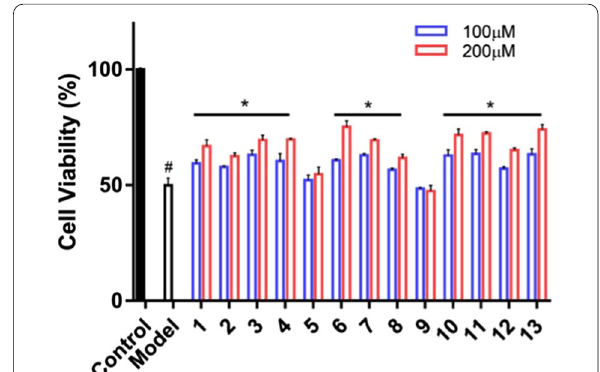
Fig. 2 Bibenzyl derivatives in D. officinale improve the survival rate of cells. # P < 0.05, significantly different from control group; *P < 0.05, significantly different from model group